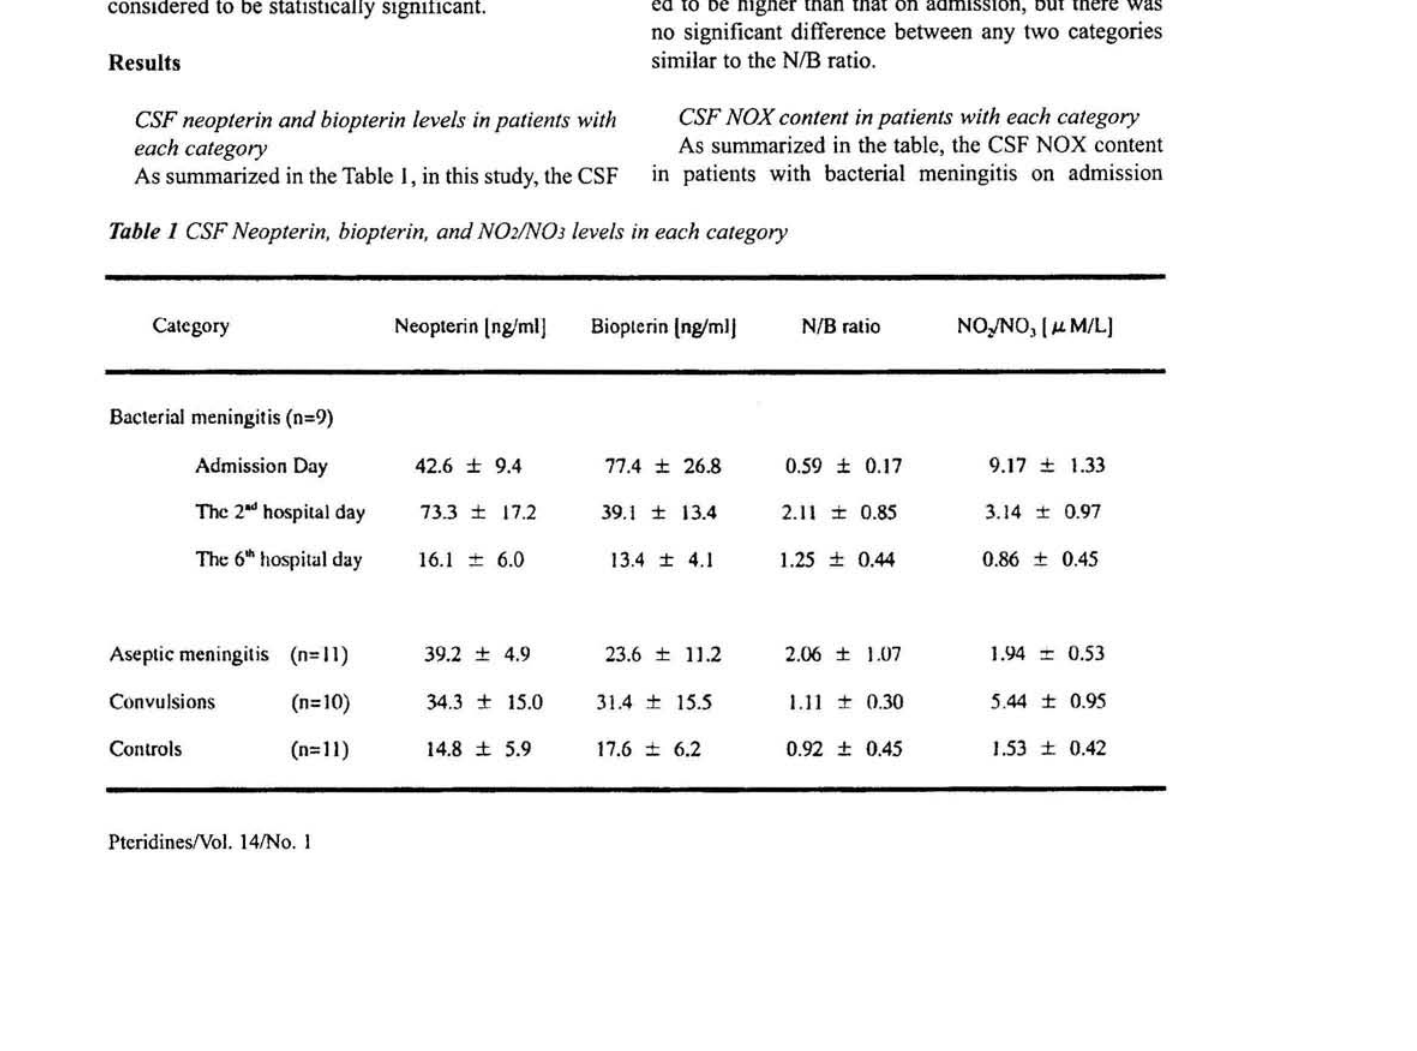
Table I CSF Neopterin, biopterin, and NO2 /NO3 levels in each